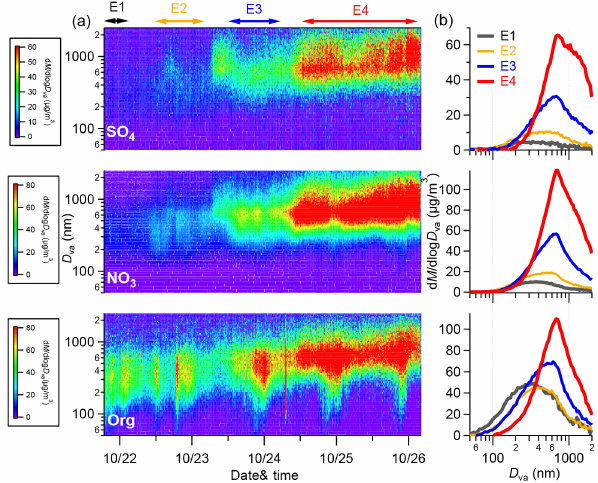
Figure 13. (a) Evolution of size distributions of sulfate, nitrate, and organics during the severe haze episode between 22 and 25 Octo- ber (Fig. 12). (b) Average size distributions of sulfate, nitrate, and organics during the four stages of